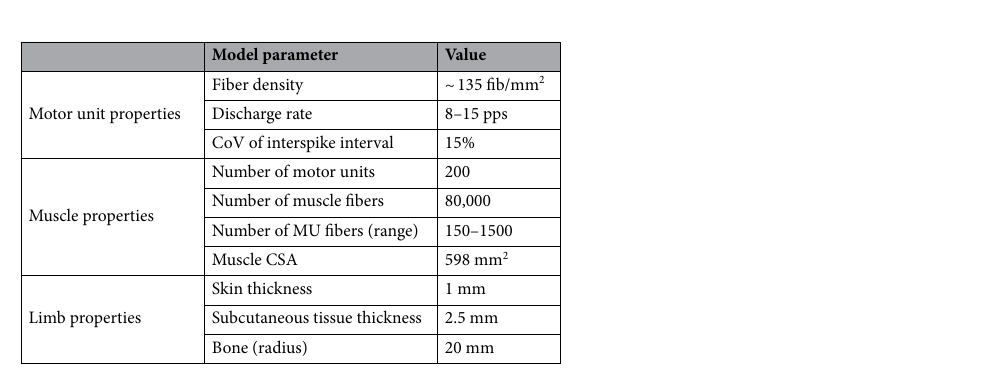
Table 1. Parameters of the cylindrical model.